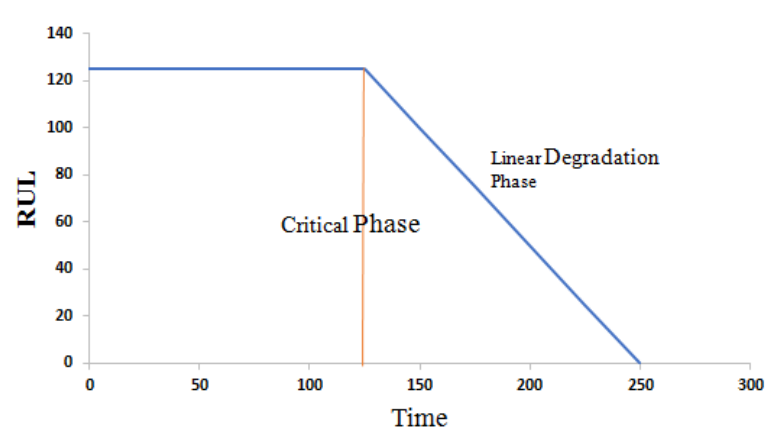
Figure 9. Piece-wise linear remaining useful life (RUL) target